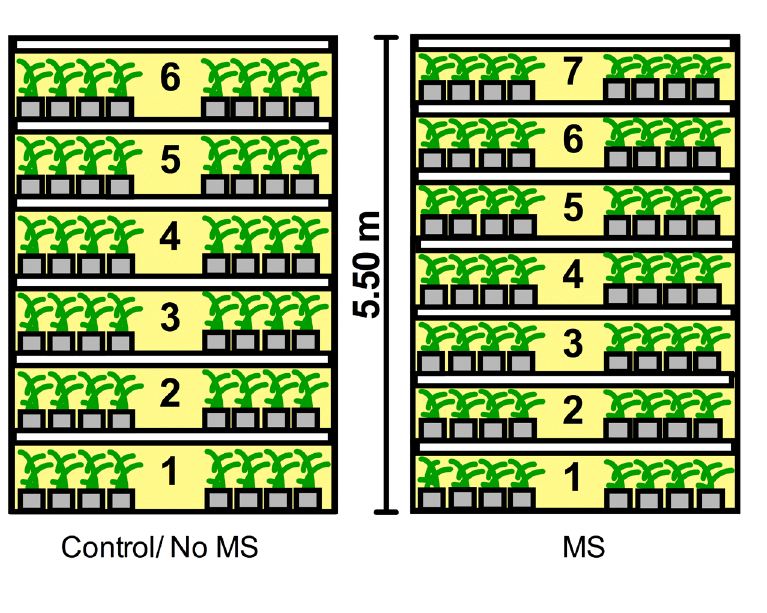
Figure 6: Theoretical Volume Utilization Efficiency (VUE) improvement potential in stacked crop production system based on the mean height reductions observed in the fruiting experiment presented. Lighting and root zone accommodations are considered in the calculation as indicated in the